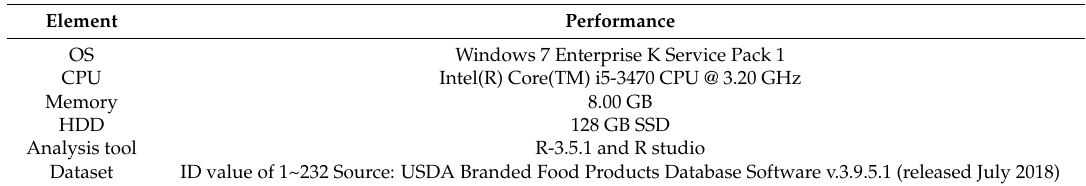
Table 4. Experimental